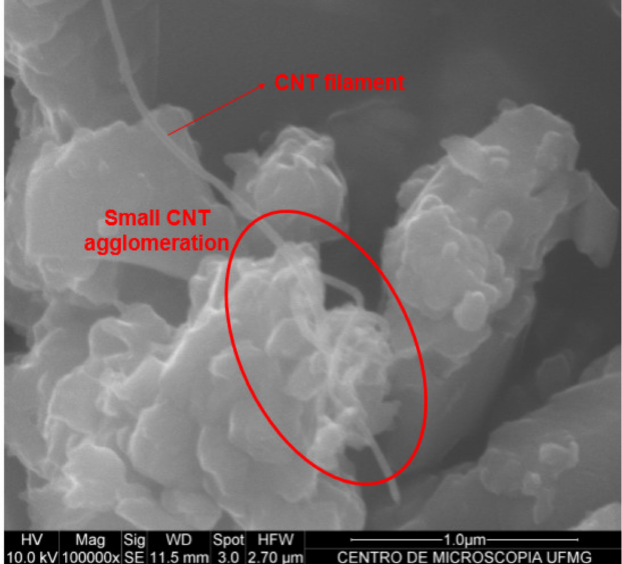
Figure 4. Scanning electron microscopy images of the anhydrous cement with 0.10% of CNTs with small